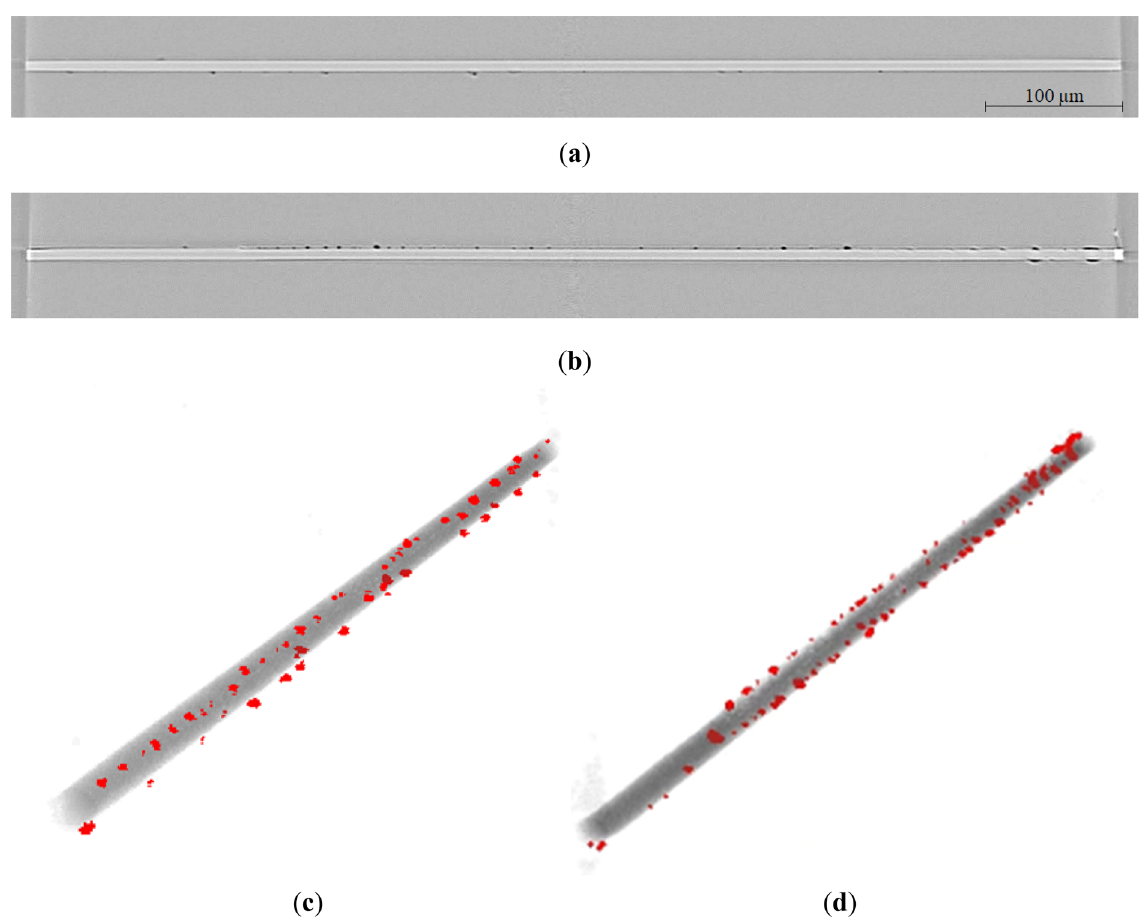
Figure 8. Reconstructed images obtained by micro-CT ( a ) before loading and ( b ) under a stress of 50 MPa, with the 3D image of the carbon fiber extracted using binarization process ( c ) before loading and ( d ) under a stress of 50 MPa. The empty spaces in the epoxy matrix are represented in red, and interfacial debonding was not clearly